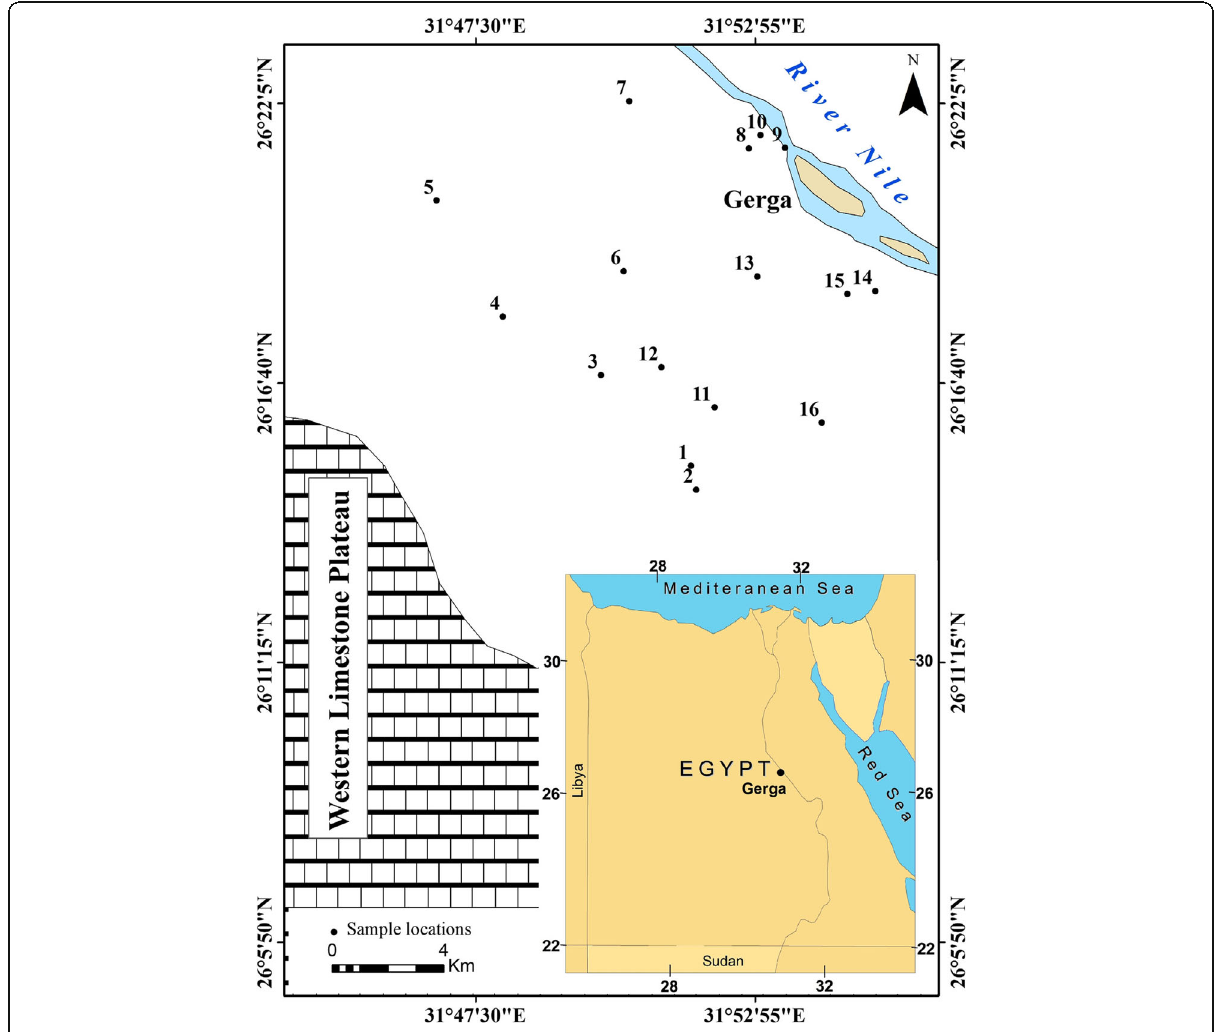
Fig. 1 Map of the study area showing soil sampling